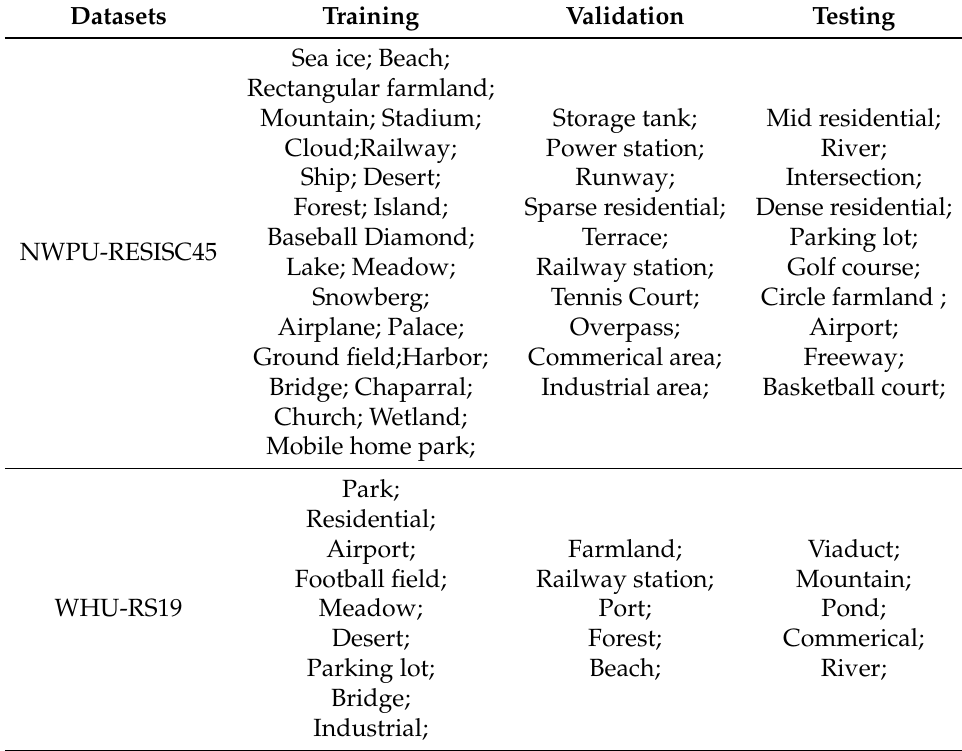
Table 1. Details of NWPU-RESISC45 dataset and WHU-RS19 dataset.